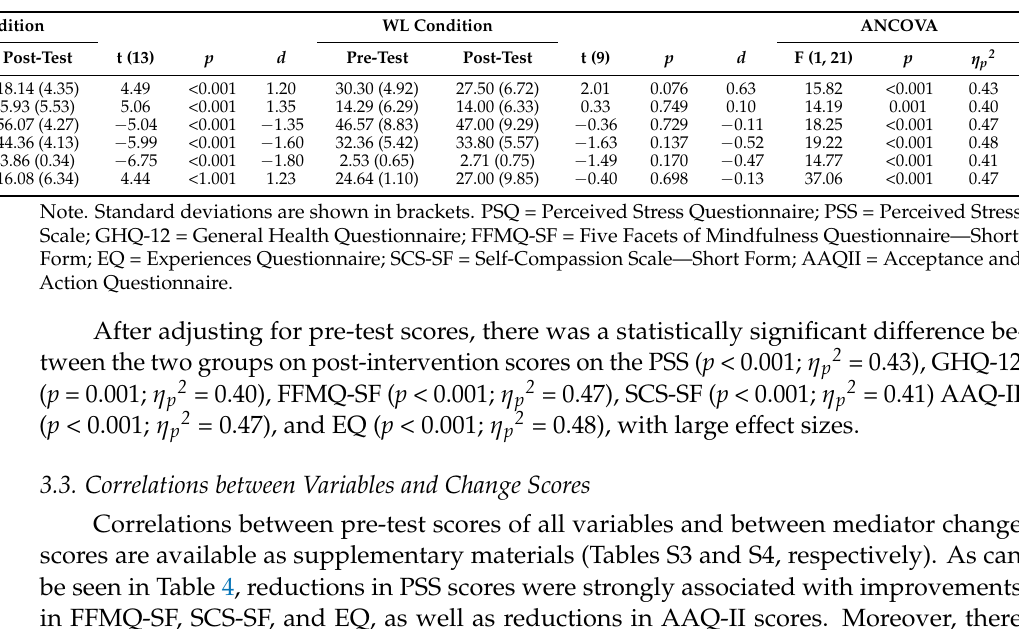
Table 3. Means, standard deviations, paired samples t -test, and ANCOVA comparing primary and secondary